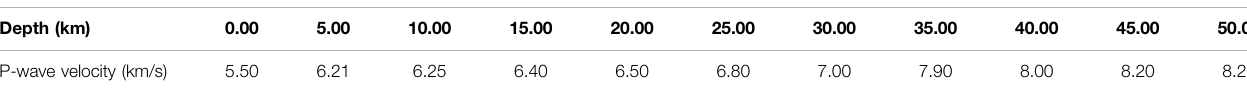
TABLE 1 | One-dimensional underground velocity structure in Hebei Province (Yu et al., 2003).